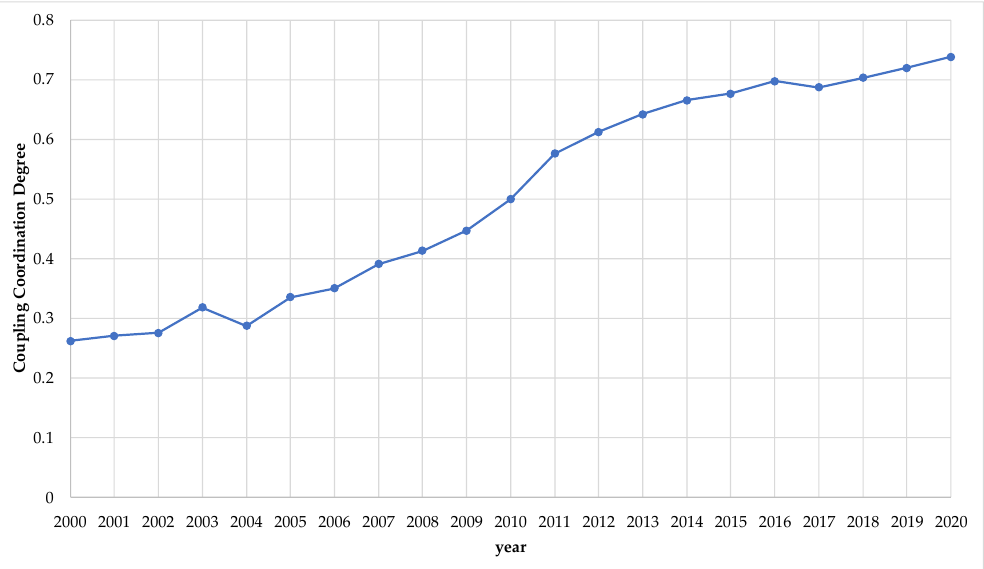
Figure 4. Time evolution of the degree of coordinated development of PRE systems in Jiangsu.